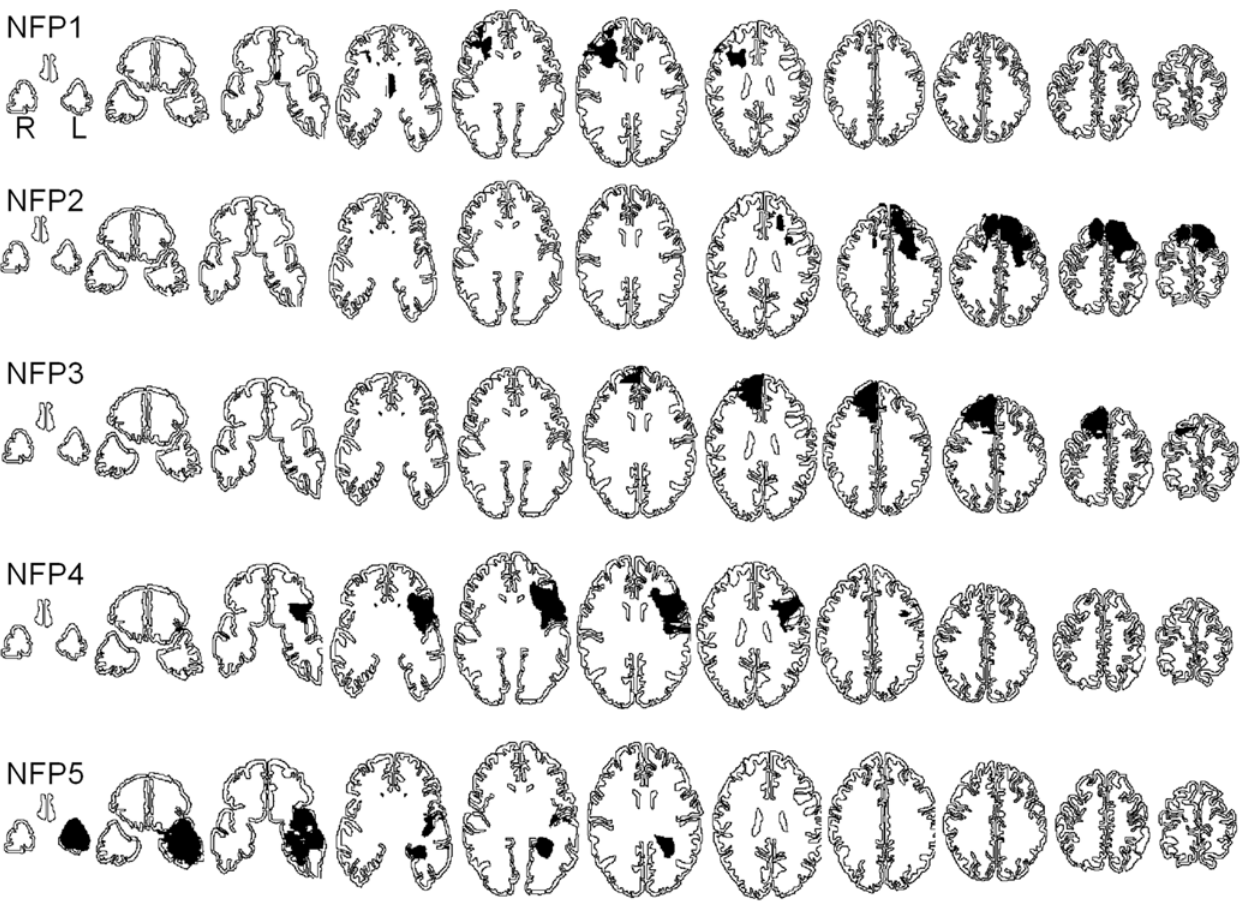
Figure 3. Reconstruction of lesions for each patient without frontopolar cortex damage (NFP1–NFP5) based on computerized tomography and MRI scans. The shaded area represents the lesion. Axial slices are displayed in radiological convention from ventral (left) to dorsal (right).